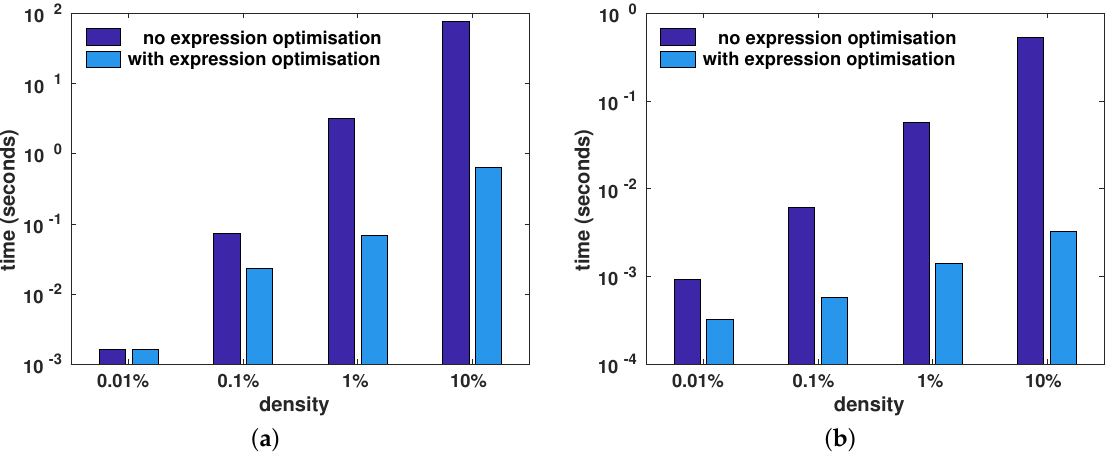
Figure 7. Wall-clock time taken to calculate the expressions ( a ) trace(A.t()*B) and ( b ) diagmat(A + B) , where A and B are randomly-generated sparse matrices with a size of 10,000 × 10,000 and various densities of non-zero elements. The expressions were calculated with and without the aid of the template-based optimisation of compound expression described in Section 3. As per Table 1, X.t() returns the transpose of matrix X , while diagmat(X) returns a diagonal matrix constructed from the main diagonal of X